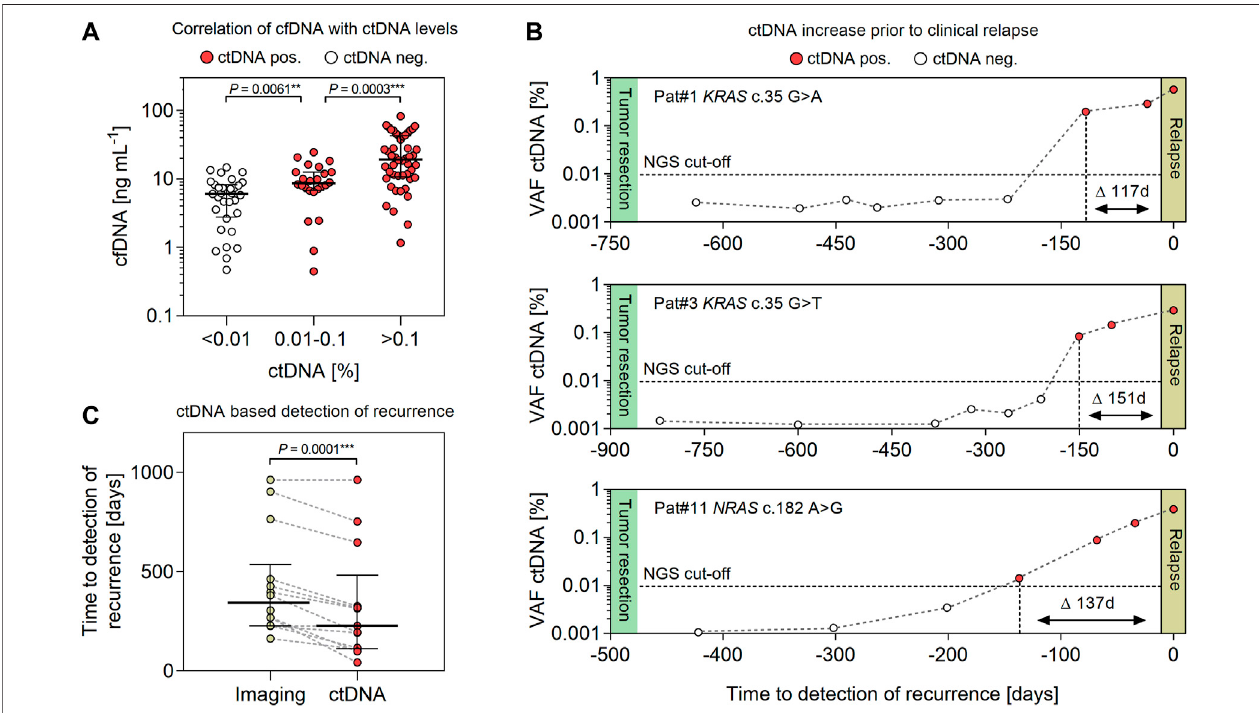
FIGURE 2 | Evaluating the feasibility of detecting ctDNA for early prediction of relapse in CRC patients. (A) Association of cfDNA with levels of ctDNA ( < 0.01%, 0.01 – 0.1% and > 0.1%) in plasma samples ( n (cid:1) 104) of CRC patients ( n (cid:1) 14). (B) Exemplary illustration of ctDNA dynamics in RAS -mutated CRC patients during adjuvant therapy post-tumor resection. The NGS detection limit is indicated at 0.01% VAF. (C) Comparing the progression free survival (PFS) of CRC patients ( n (cid:1) 14) assessed by conventional imaging-based diagnostics and NGS-based detection of ctDNA. Error bars represent median values and interquartile